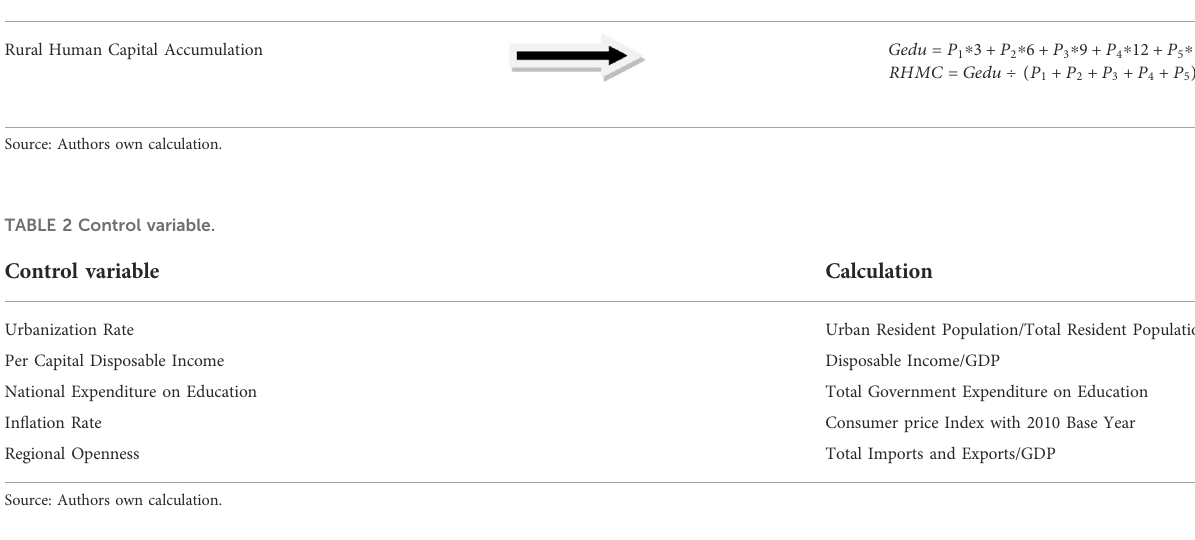
TABLE 1 Indicator system for calculating Rural Human Capital Accumulation. Variable Contain dimensions